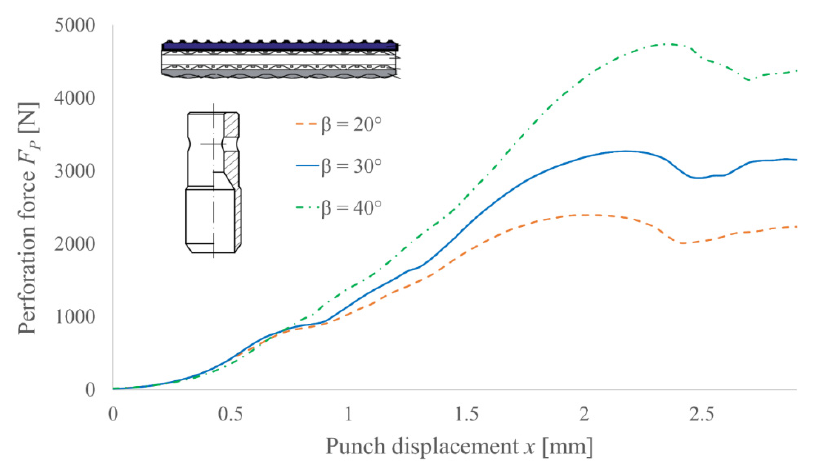
Figure 11. Experimental results of the perforation force measurement for PO punches with diameter d = 10 mm and various angles of the blade β for TFL10S belt.